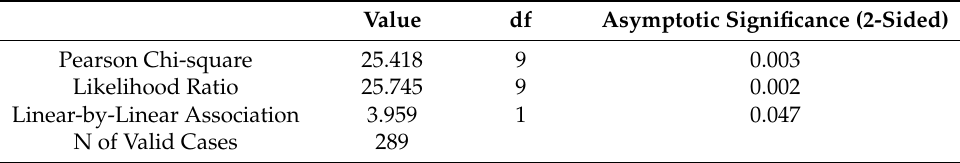
Table 7. Chi-square test on the correlation between respondents’ experience and the impact of digitization on the process of assisting managerial decisions based on the data provided by the financial/accounting information system.